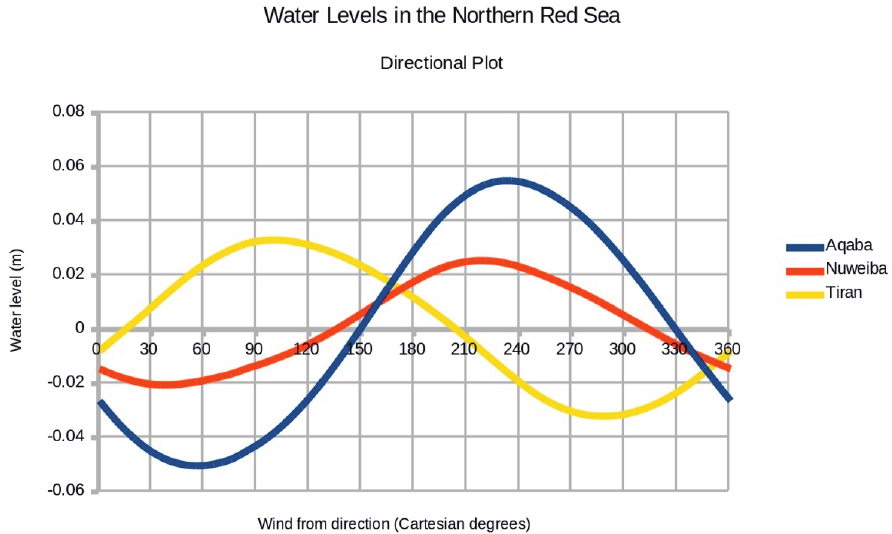
Figure 7. Directional plot for Suez, Adabiya, and Al-Wajh. Cartesian degrees are: 0° and 360° = east; 90° = north; 180° = west; 270° = south.